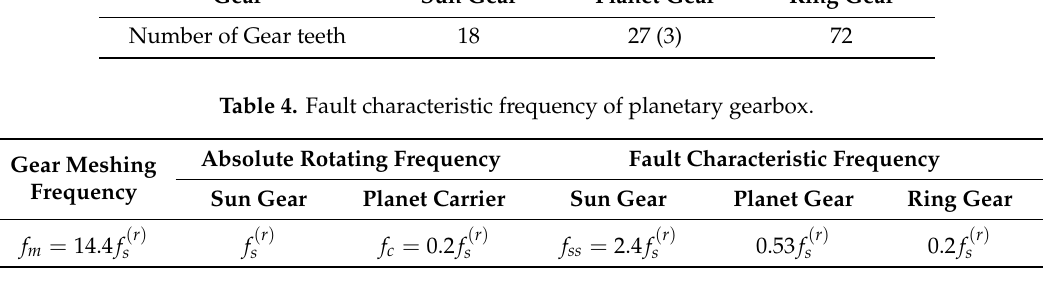
Figure 13. The damage of the sun gear.